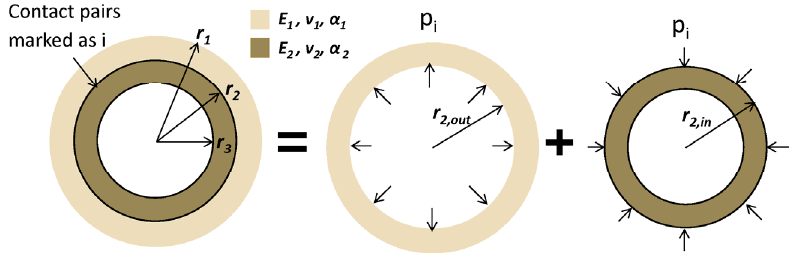
Figure 2. Superposition principle for interference problem of bi-layer thick-walled cylinders (BTC). The inner and outer cylinders are represented by two different colors. E , v, and α represent Young modulus, Poisson's ratio, and coefficient of thermal expansion, respectively, and the index 1 and 2 represent outer and inner cylinders, respectively. The pressure on the contact surface is p i . Before the contacting, the inside radius of the outer cylinder is r 2,out , and the outside radius of the inner cylinder is r 2,in . After the contacting, the radius of the contact surface is r 2 , and the inside radius of the inner cylinder is r 3 , and the outside radius of the outer cylinder is r 1 . Appl. Sci. 2016 , 6 , 167